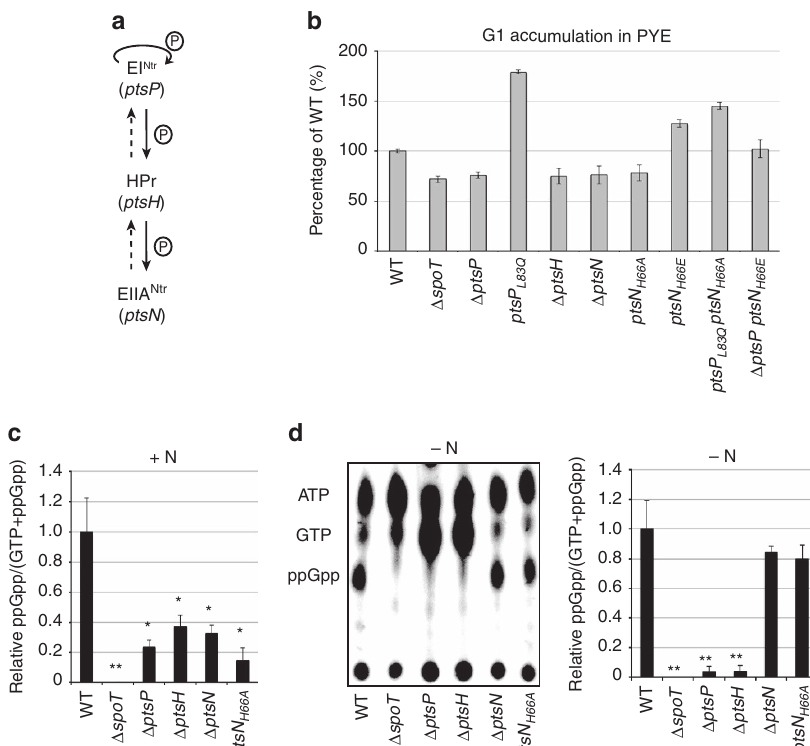
Figure 5 | PTS Ntr modulates (p)ppGpp accumulation. ( a ) Schematic representation of the PTS Ntr pathway in C. crescentus . ( b ) The PTS Ntr components EI Ntr , HPr and EIIA Ntr control G1/swarmer lifetime. G1 proportion was measured in wild-type (WT; RH50), D spoT (RH1755), D ptsP (RH1758), ptsP L83Q (RH1748), D ptsH (RH1621), D ptsN (RH1819), ptsN H66A (RH2019), ptsN H66E (RH2017), ptsP L83Q ptsN H66A (RH2018), D ptsP ptsN H66E (RH2016) grown in complex media (PYE) and normalized to the WT (100%). Error bars ¼ s.d.; n ¼ 3. ( c , d ) (p)ppGpp accumulation is modulated by PTS Ntr . Intracellular levels of (p)ppGpp detected by TLC after nucleotides extraction of WT (RH50), D spoT (RH1755), D ptsP (RH1758), D ptsH (RH1621), D ptsN (RH1819) and ptsN H66A (RH2019) grown ( c ) in þ N or ( d ) (cid:2) N conditions. Error bars ¼ s.d.; n ¼ 3. Statistically significant differences by Student’s t -test in comparison with the WT are indicated as * P o 0.05% and ** P o 0.01% ( n ¼ 3).